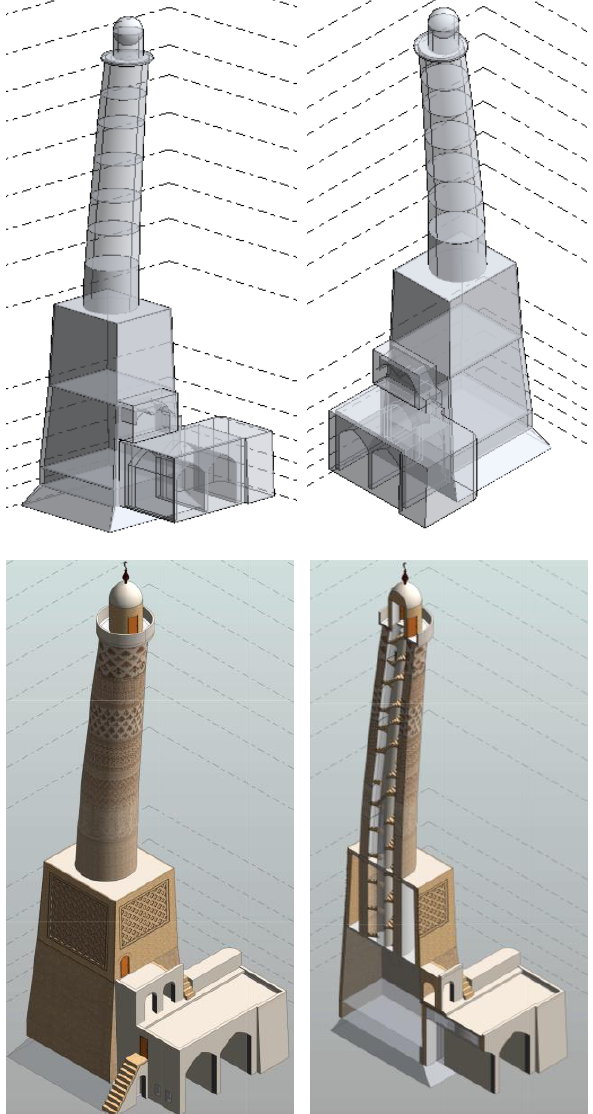
Figure 6. The Base building mass after tracing the point cloud (top); the final HBIM with parametric components and ornamentation